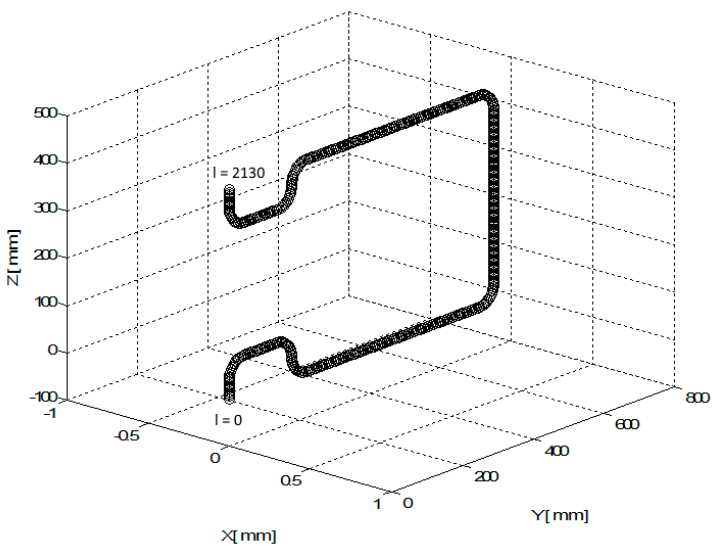
Figure 17. Test 1—3D view of the non-bearing core frame location in LCS .